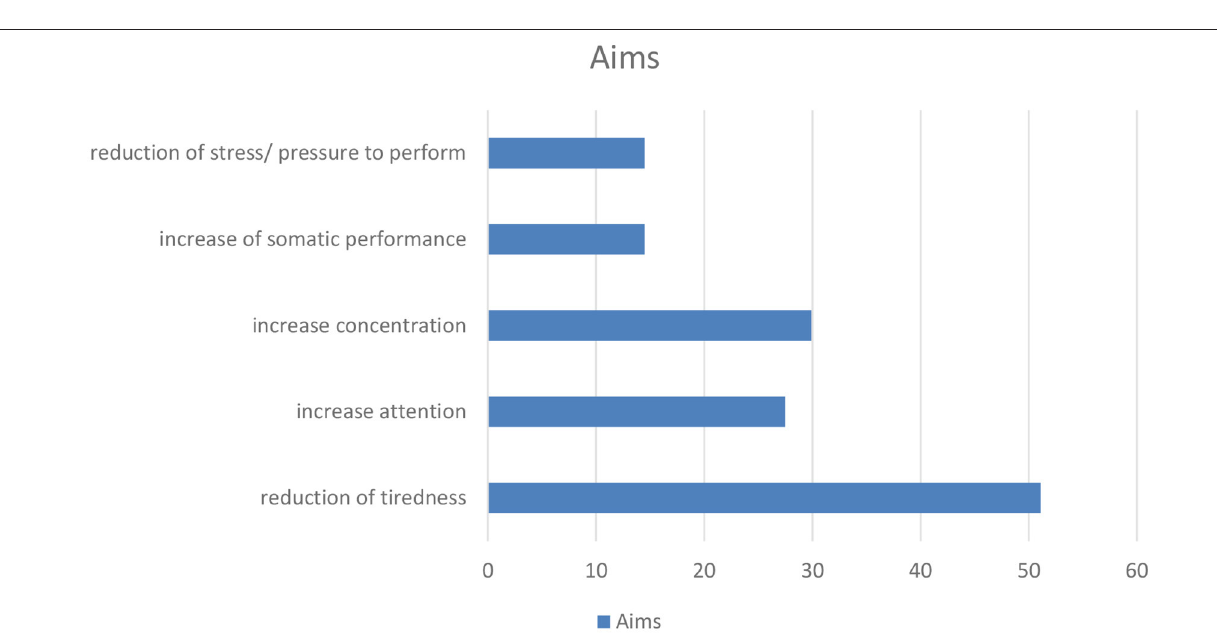
results. Reason for these differences might include the rural area of Neubrandenburg with possibly less opportunities of getting inappropriate access to drugs on prescription. Another reason could also be different regulations and laws varying from Switzerland to Germany and participant’s average